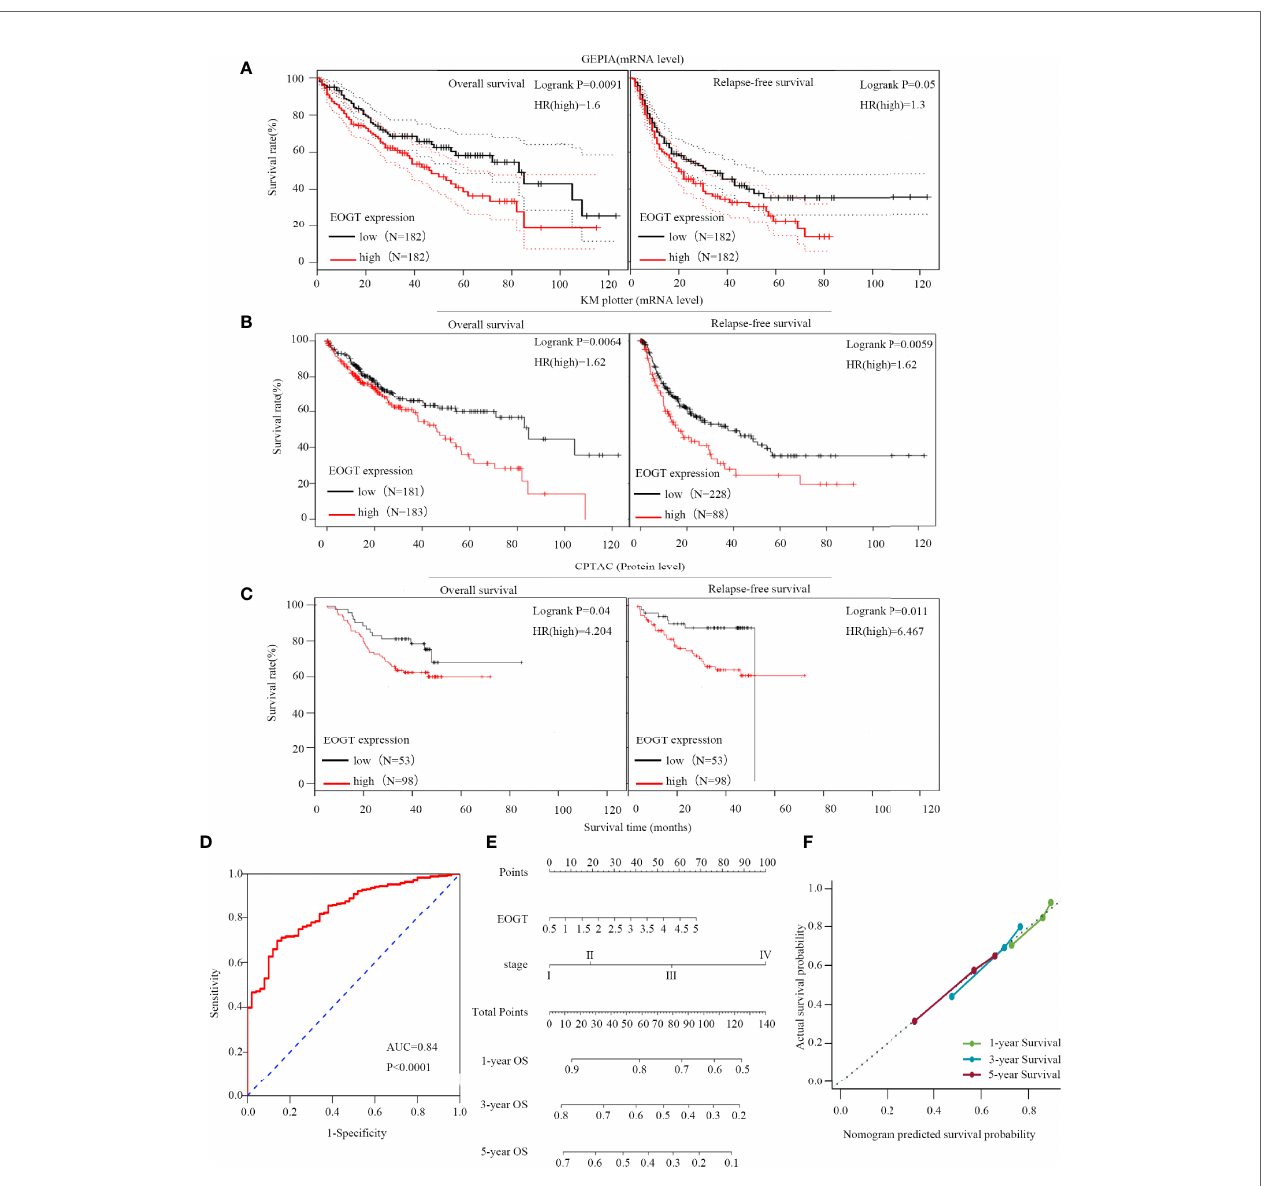
FIGURE 2 | High-EOGT expression was associated with poor prognosis in HCC samples. (A, B) GEPIA and the Kaplan – Meier (KM) plotter were used to construct the survival curves of OS and RFS based on EOGT expression in HCC samples. (C) The KM survival curves based on EOGT expression at the protein level in HCC samples were determined by the CPTAC database. Validation of diagnostic value of elevated EOGT expression for HCC samples using the ROC curve (D) . Nomogram for HCC samples (E) and the calibration curve of the nomogram (F) for predicting OS at 1, 3, and 5 years. Actual OS was plotted on the y -axis; nomogram predicted probability of OS was plotted on the x